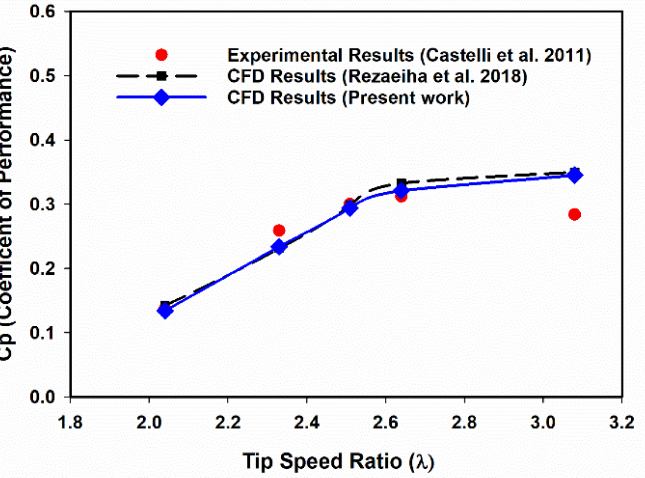
Figure 4. Validation of numerical model with experimental results [36,41] and other standard numerical results.